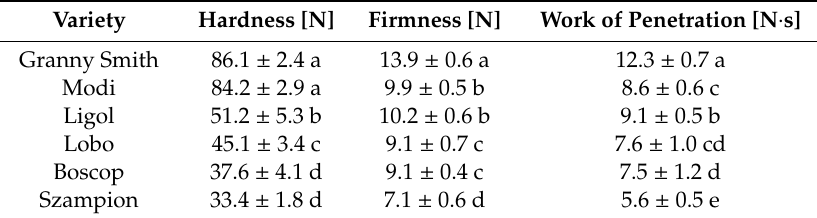
Table 2. Variety-dependent textural properties of